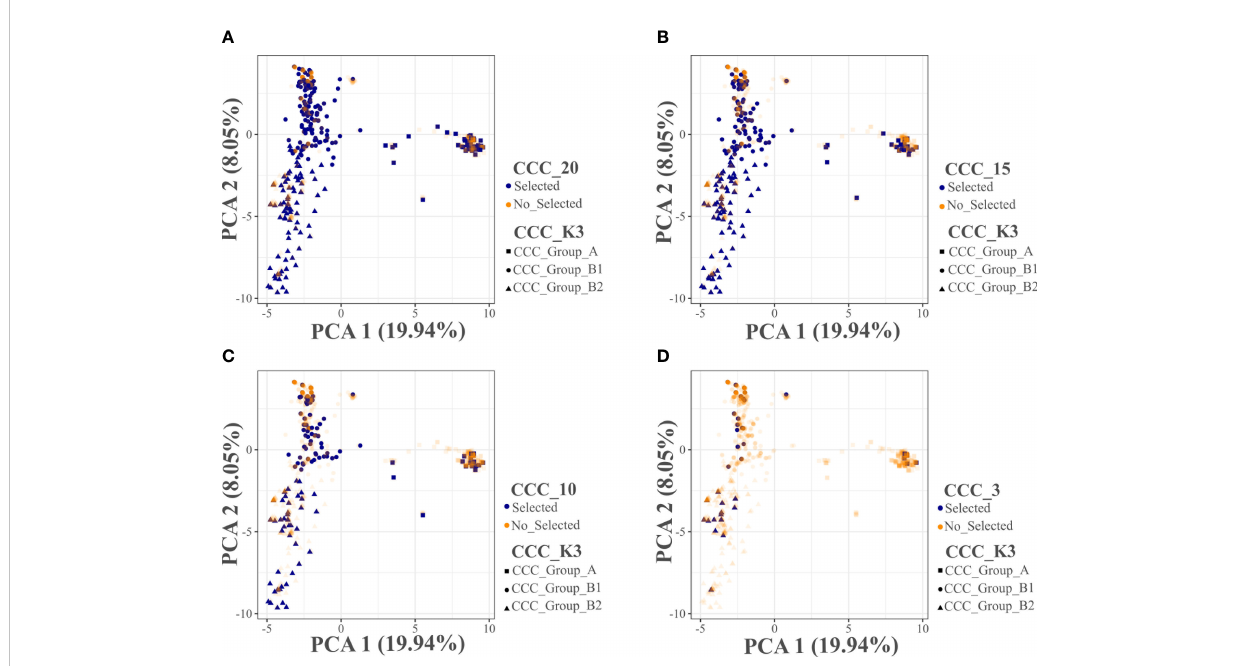
FIGURE 5 Principal Component Analyses (PCA) distribution of the selected entries in three core and one mini-core collections evaluated for the Colombian Central Collection (CCC) of potatoes. (A) Core collection size of 20 percent (CCC_20), (B) Core collection size of 15 percent (CCC_15), (C) Core collection size of 10 percent (CCC_10), and (D) Mini-core collection size of 3 percent (CCC_3). The CCC_K3 information in (A – D) corresponds to the three genetic groups suggested by the CCC population structure analysis using the NbCluster